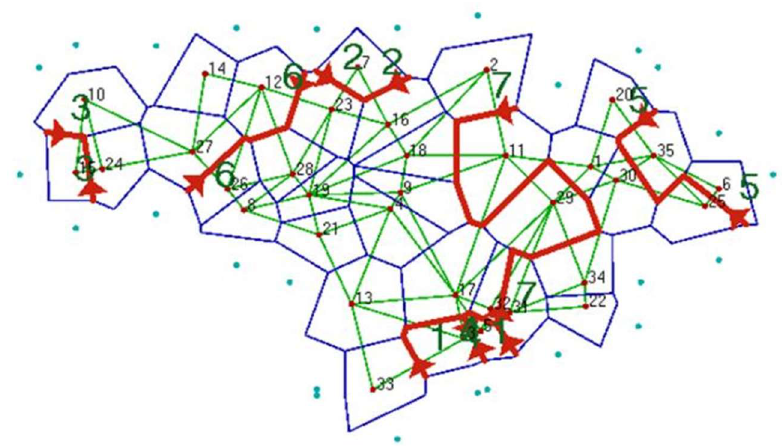
Figure 3. Results of the Monmonier’s algorithm modeling (the BARRIER software) of the geograph- ical barriers for significant shifts in the allele frequencies based on the chloroplast microsatellite markers. The map shows a Delaunay triangulation plot between the sampled populations on a simplified map of Lithuania. The larger numbers at the barriers indicate the significance of the barriers with the 1st barrier being the most significant and the 7th barrier—least significant. The small numbers at the dots indicate